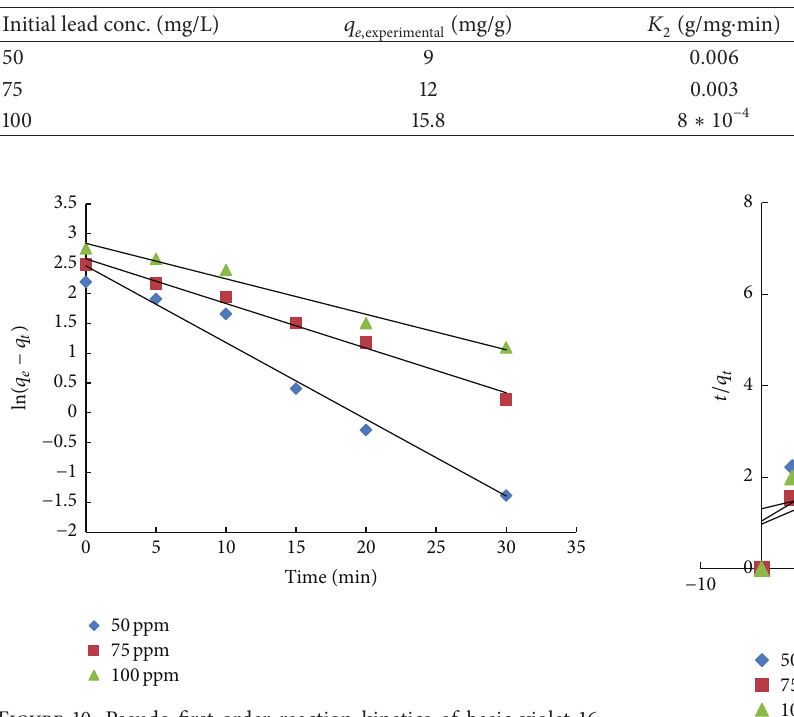
Figure 10: Pseudo-first-order reaction kinetics of basic violet 16 onto composite sheet matrix. Figure 11: Pseudo-second-order reaction kinetics of basic violet 16 onto composite sheet